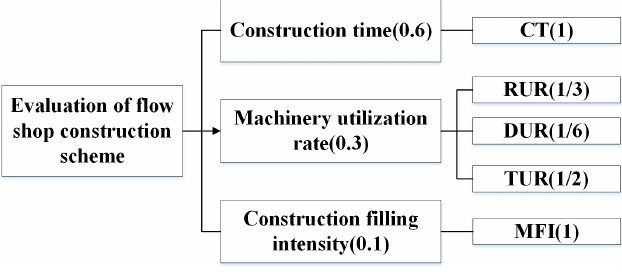
Figure 7. Flow chart of construction stage and zone optimization with enhanced whale optimization algorithm (EWOA).